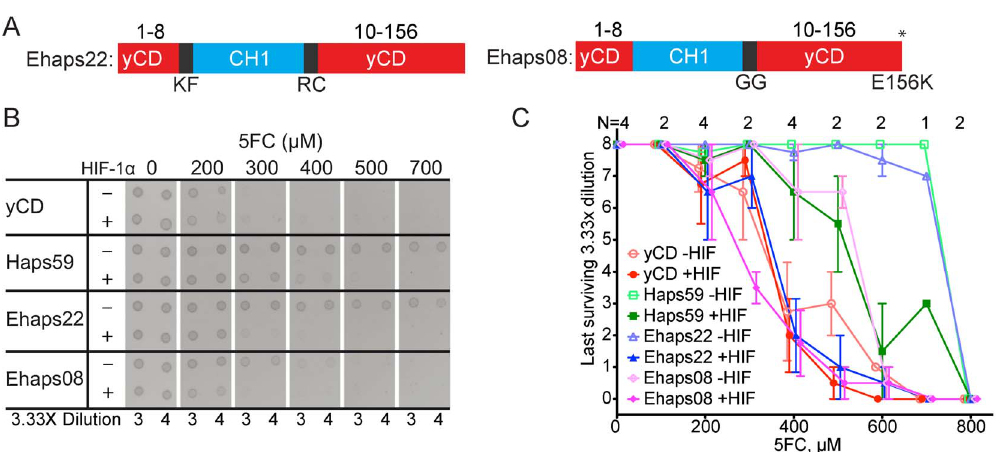
Figure 3. Characterization of Ehaps22 and Ehaps08 in E. coli. (A) Diagram of Ehaps22 and Ehaps08 sequences. Ehaps22 was selected from the linker library containing 2-amino acid N- and C-terminal linkers. Ehaps08 was selected from the random mutagenesis library of Haps59. Numbers above indicate the amino acid residues in yCD. Letters below indicate the 1-letter abbreviation of the amino acid sequence of the corresponding linker or mutation. (B) Representative 5FC dot toxicity assay on cells expressing yCD, Haps59, Ehaps22, or Ehaps08. Serial dilutions of equal density log phase cultures containing either pGA ( 2 HIF-1 a , i.e. not expressing HIF-1 a ) or pGA-HIF ( + HIF-1 a , i.e. expressing HIF-1 a ) were spotted on minimal media plates containing increasing concentrations of 5FC. (C) Quantification of dot toxicity assay. The highest dilution at which growth was observed for each culture on each plate is plotted against the concentration of 5FC in each plate. The number of replicates of each plate is listed above. Error bars represent max and min for N 5 2 plates and standard deviation for N 5 4. See Fig S1, S2, S3, and S4 for replicate